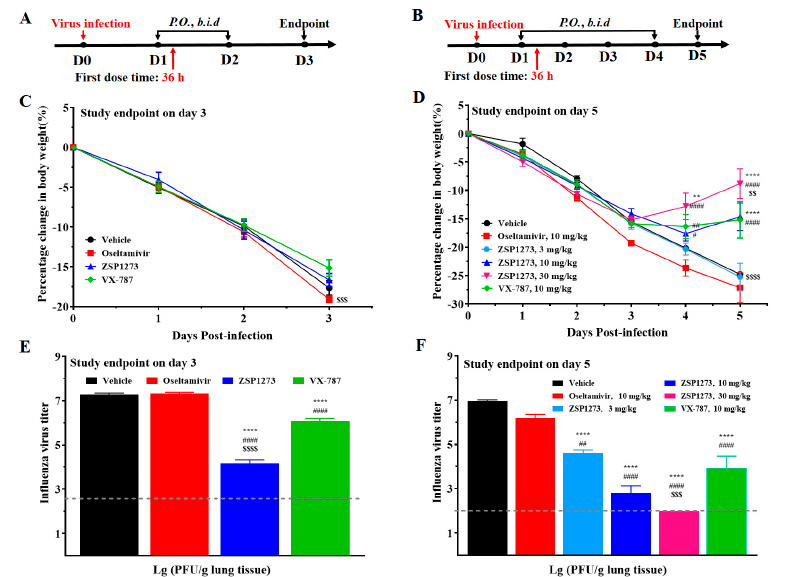
Figure 4. The antiviral activity of ZSP1273 in murine infection experiment I (n = 6, mean ± SEM): ( A ) Flowchart of the experiment (study endpoint on day 3); the day of H1N1 infection is defined as day 0, the first day after infection is denoted as day 1, and so forth. ( B ) Flowchart of the experiment (study endpoint on day 5). ( C ) Change in body weight on day 3. ( D ) Body weight change on day 5. ( E ) Influenza A virus titers on day 3. ( F ) Influenza A virus titers on day 5. The viral titer lower than the LOD (2.0 log10) was calculated as 2.0. Note: ** p < 0.01, **** p < 0.0001 (vs. vehicle); # p < 0.05, ## p < 0.01, #### p < 0.0001 (vs. oseltamivir); $$ p < 0.01, $$$ p < 0.001, $$$$ p < 0.0001 (vs. VX − 787).